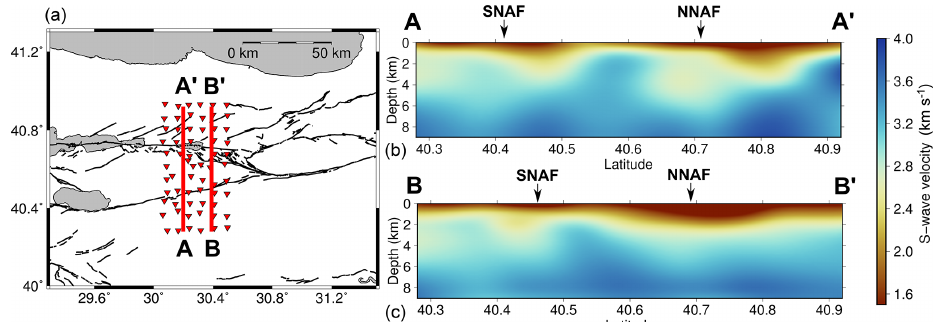
Figure 7. (a) Map of the Izmit–Adapazari region showing station locations of the DANA network as red triangles and mapped faults as black lines. Thick red lines indicate the location of the vertical profiles taken through the S-wave velocity model along lines A–A (cid:48) and B–B (cid:48) . (b) Vertical S-wave velocity profile between A and A (cid:48) . (c) Vertical S-wave velocity profile between B and B (cid:48) . The profiles show S-wave velocity between the surface and 9km of depth. The approximate locations of the surface traces of the northern and southern branches of the NAFZ are indicated by NNAF and SNAF, respectively.